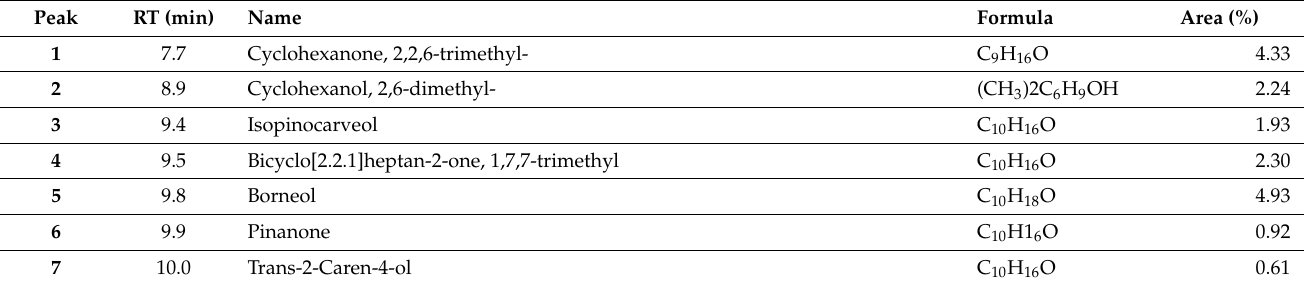
Table 4. Chemical compounds identified in the ethanolic extract of Cistus ladanifer bar.